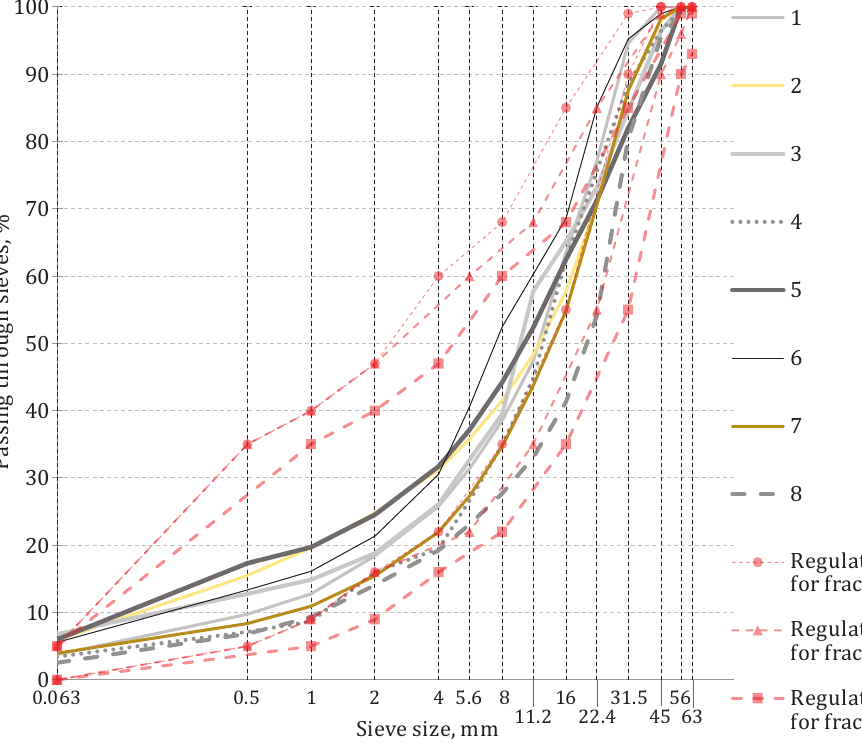
Figure 1. Scheme of aggregate particle size distributions of the